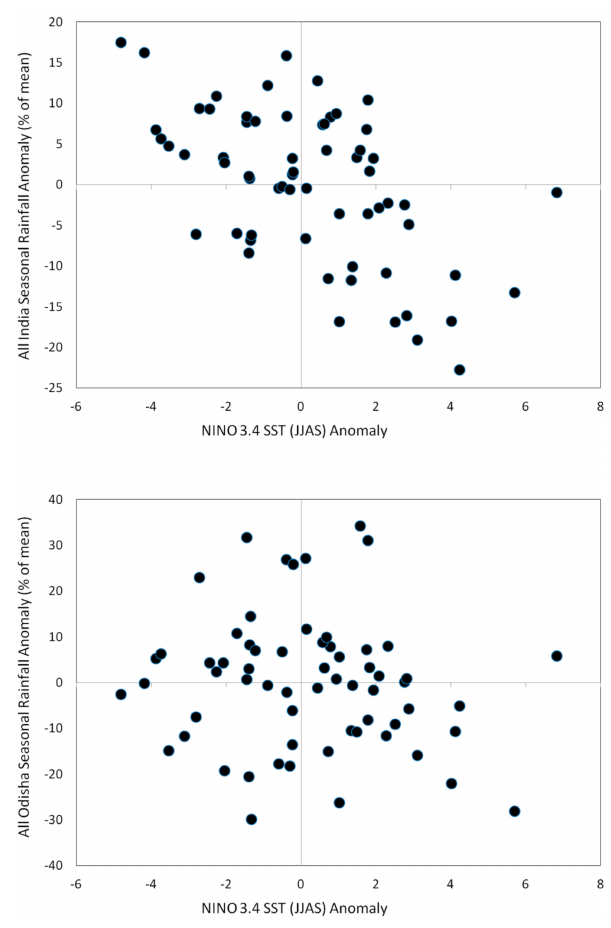
Figure 9. Scatterplot of the JJAS NINO 3.4 SST anomaly and the JJAS rainfall anomaly over all of India ( top ) and Odisha ( bottom ) for the period